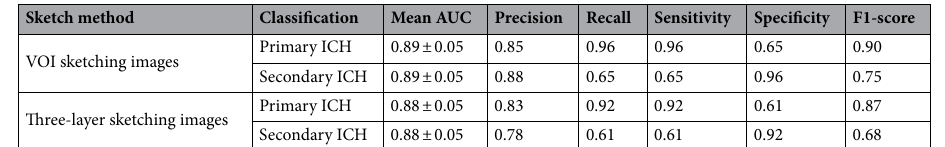
Table 6. Efficacy and stability of SVM classifier for predicting the differential diagnosis of primary and secondary ICH based on two sketching methods.